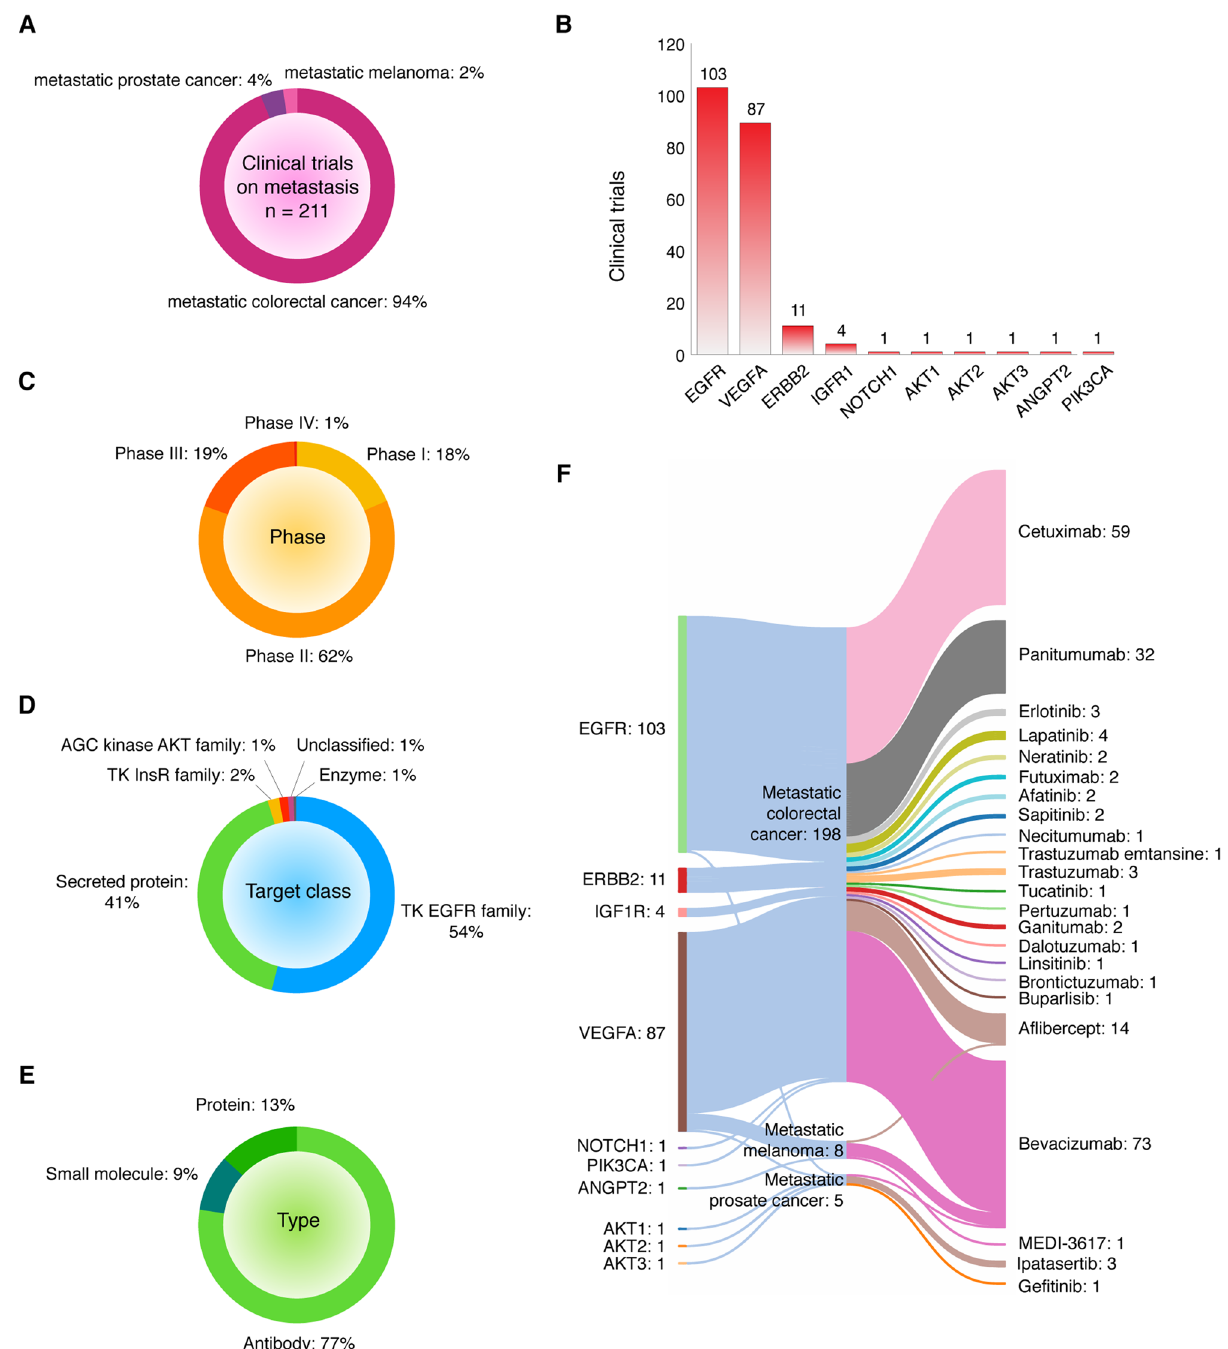
Figure 9. Overview of clinical trials of drugs focused on metastasis. ( A ) Percentage of clinical trials per cancer type. ( B ) Hypoxia-related proteins with highest number of clinical trials on metastasis. ( C ) Phase of clinical trials where drugs are involved. ( D ) Target class. ( E ) Type of drugs. ( F ) Sankey plot showing the therapeutic targets, cancer types, and drugs involved in clinical